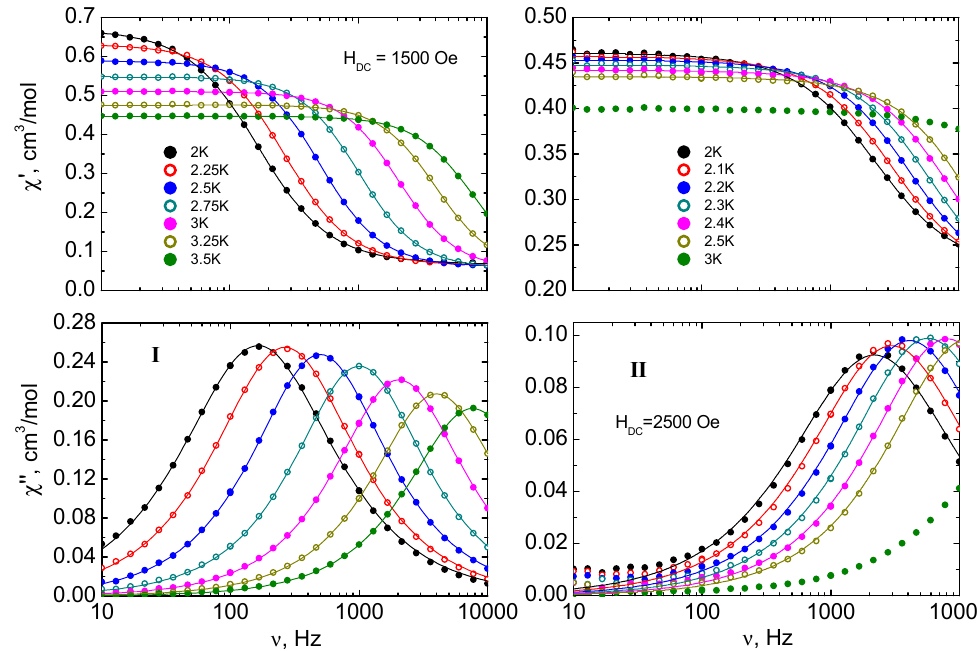
Figure 3. Frequency dependences of the real ( χ ’, top) and imaginary ( χ ", bottom) parts of the AC magnetic susceptibility at di ff erent temperatures for complexes I (left, H = 1.5 kOe, T = 2-3.5 K) and II (right, H = 2.5 kOe, T = 2-3 K). Lines show approximations of the data by the generalized Debye model.